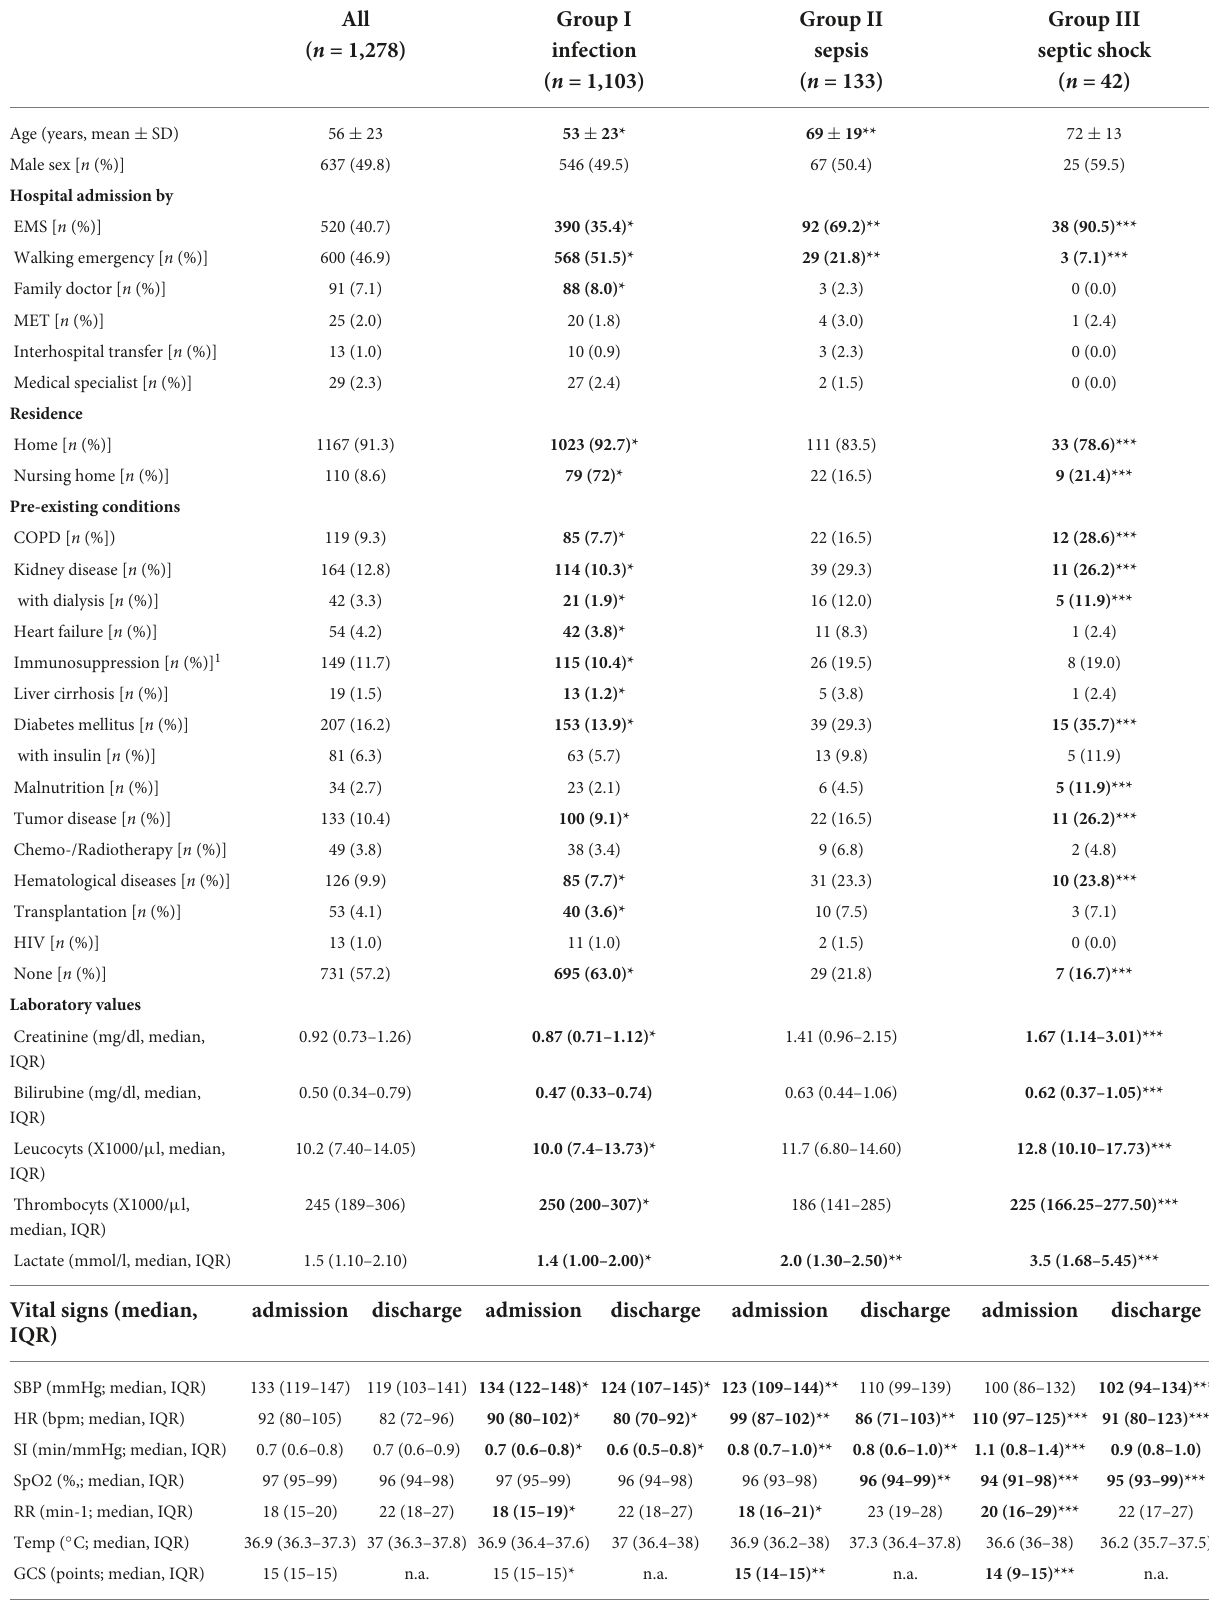
TABLE 1 Patient characteristics of the patients suffered from infection, sepsis, and septic shock in the emergency department.